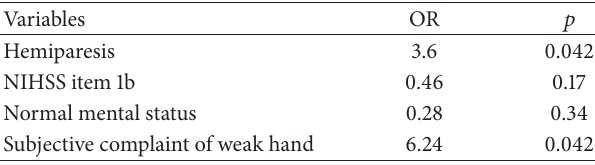
Table 4: Etiologies of stroke-mimics.